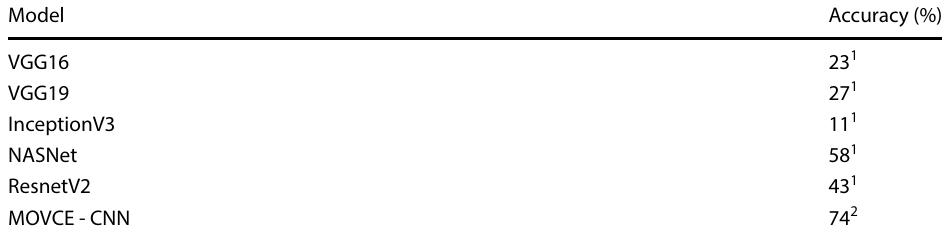
1 Native accuracy on the perturbed Bird image without any training 2 Test accuracy on the